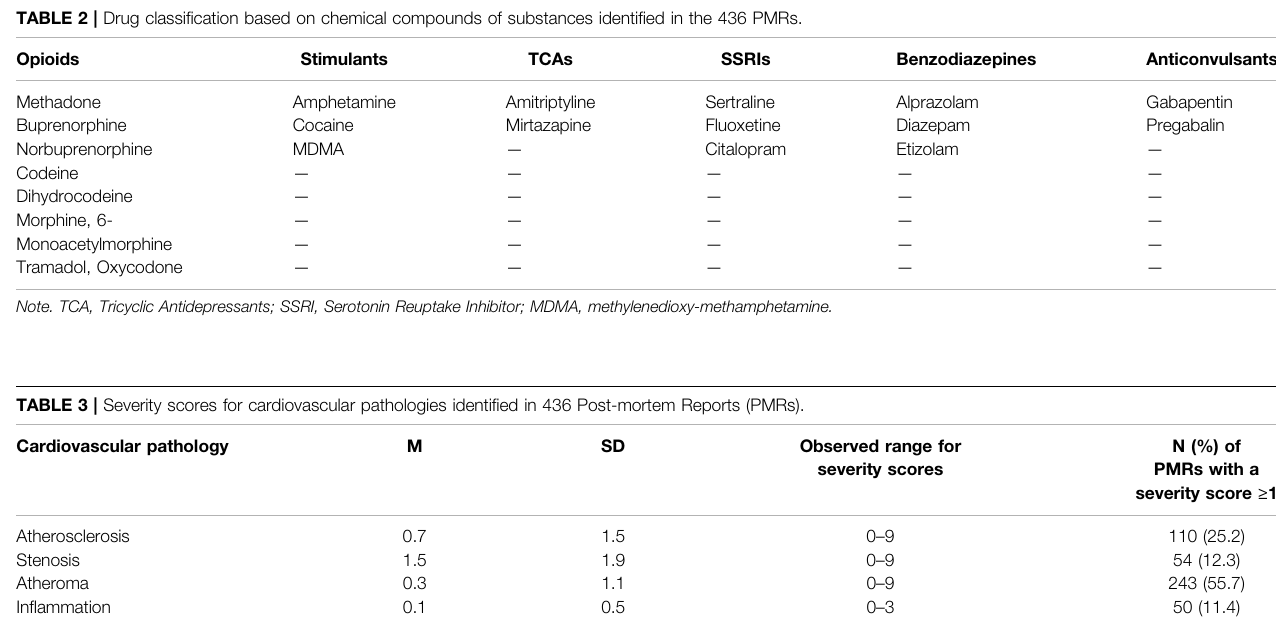
TABLE 2 | Drug classi fi cation based on chemical compounds of substances identi fi ed in the 436 PMRs. Opioids